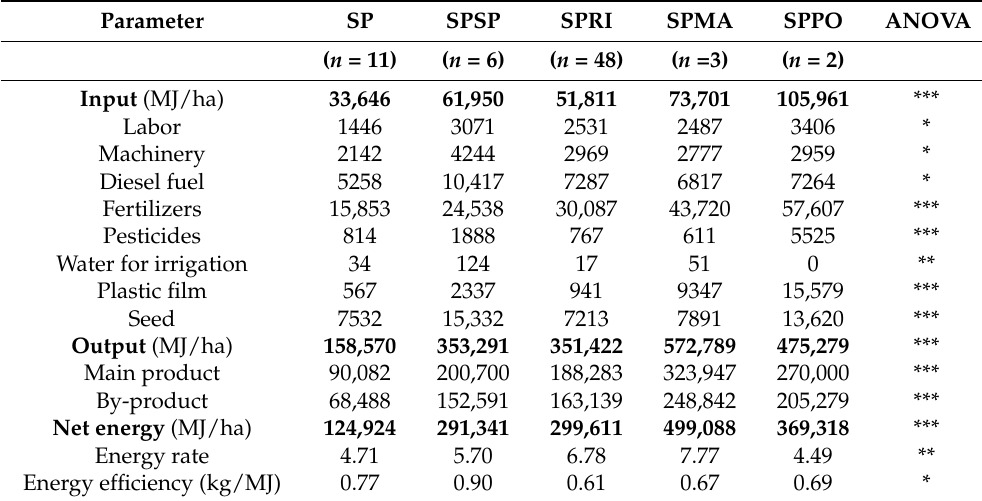
Energy input and output for five sweet-potato-based cropping systems in Guangdong province.